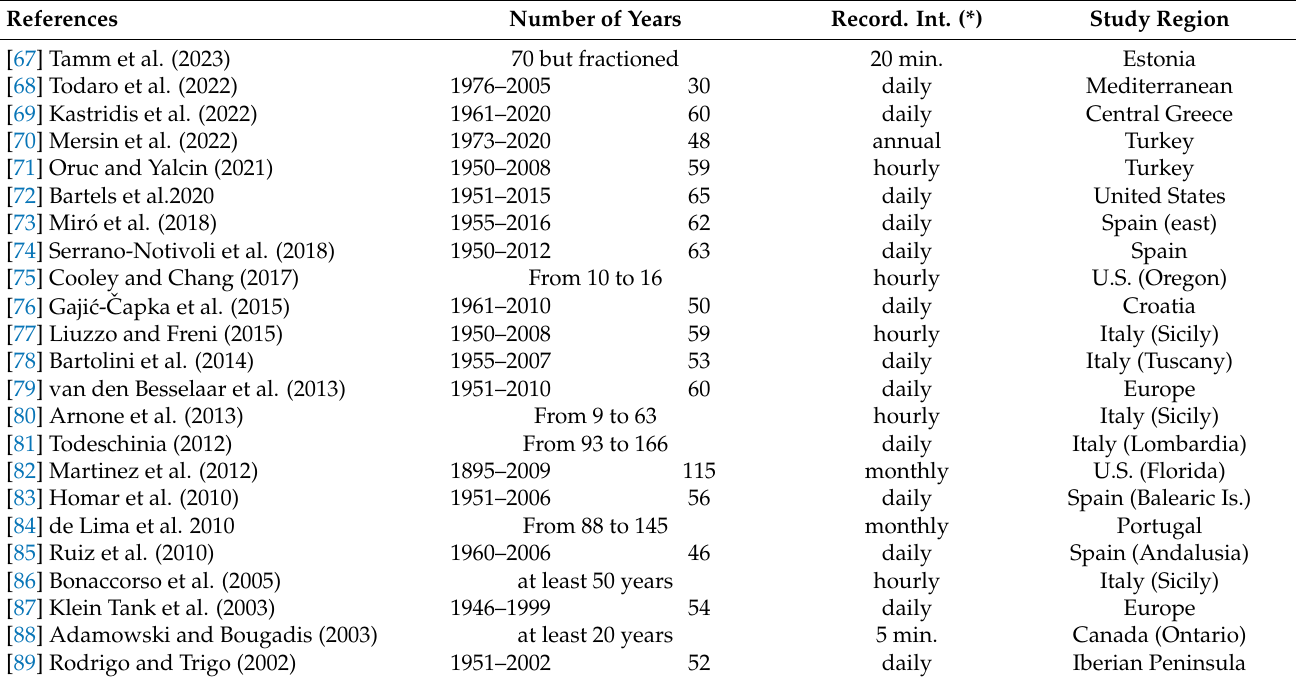
Table 4. References on precipitation trends over the last 20 years in the Mediterranean, Europe, and North